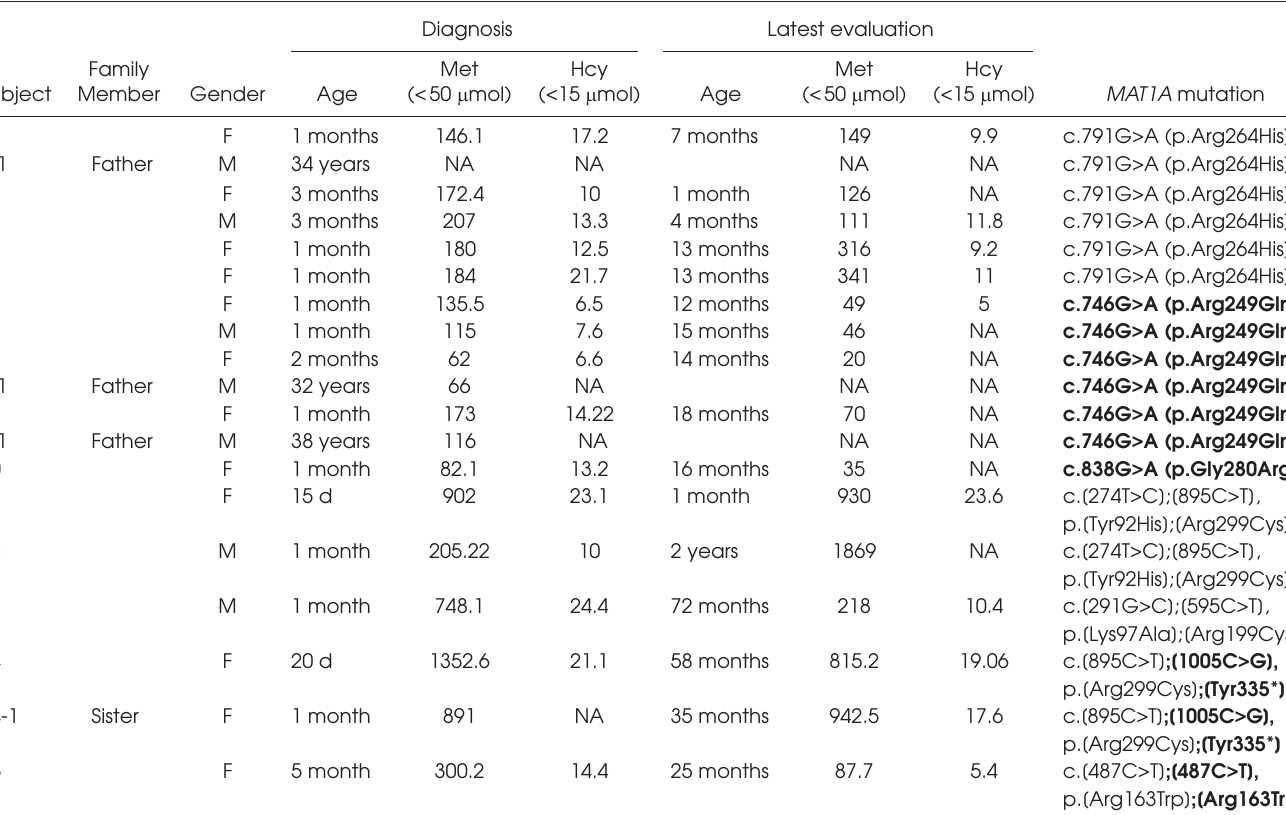
Table 1. Clinical and molecular characteristics of patients and family members with MAT I/III